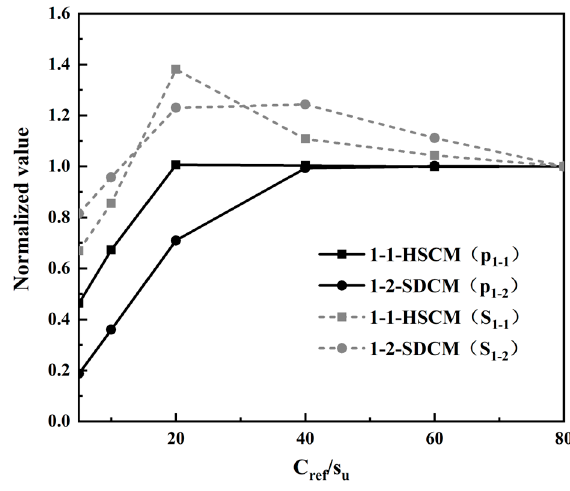
Figure 9. Normalized curves of load and displacement .